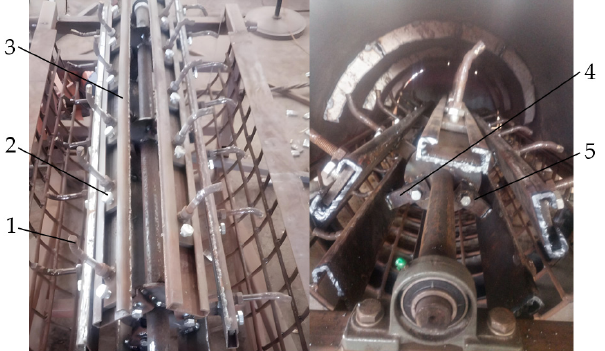
Figure 3. The internal structure of the pod-picking roller: 1—bending tooth; 2—axial slider; 3—axial sliding chute; 4—radial slider; 5—radial sleeve.